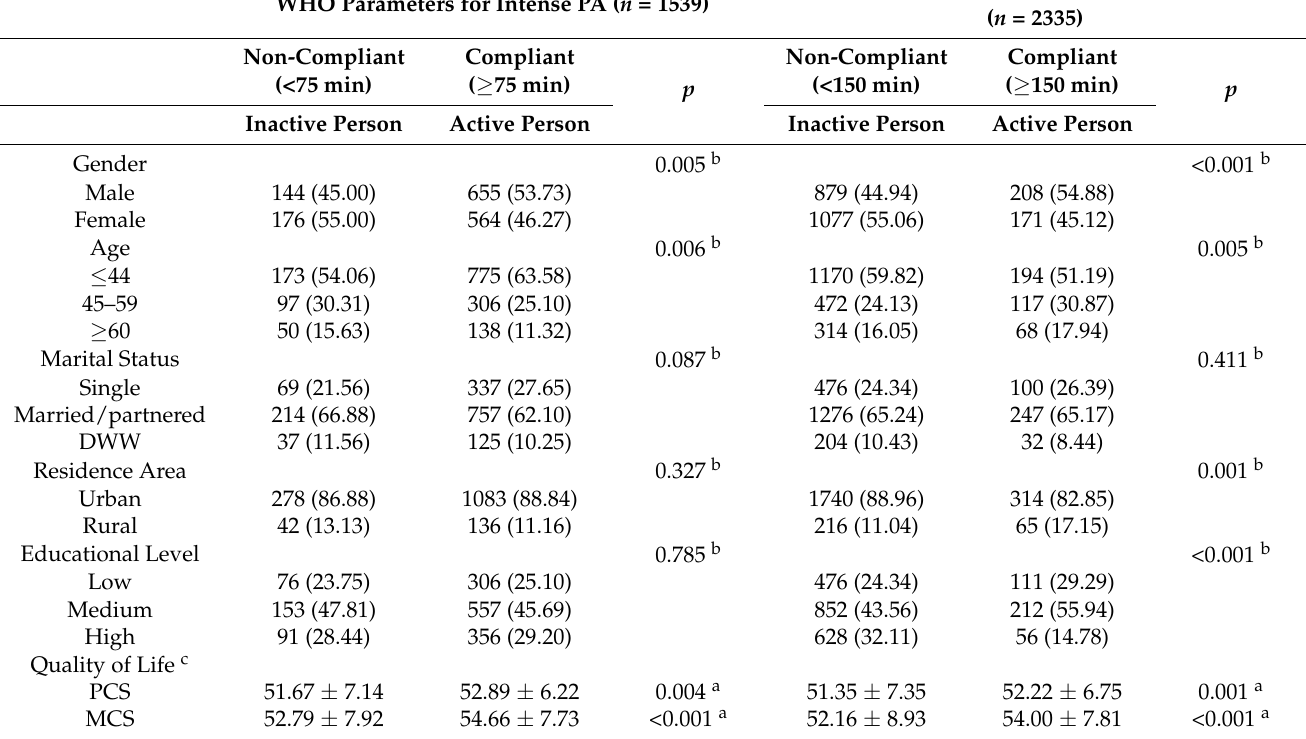
Table 4. Comparison of compliance with the WHO-designated parameters for intense and moderate PA (minutes) according to sociodemographic characteristics.